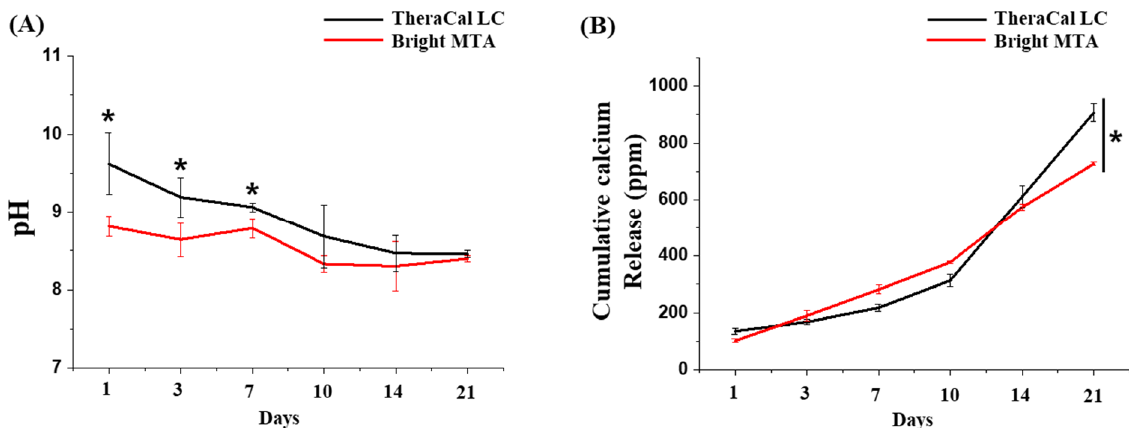
Figure 3. Ion release and pH changes from TheraCal LC and bright MTA capping over time. ( A ) The pH change was similar between TheraCal LC and bright MTA capping (n = 5). Asterisks (*) indicate statistical significance between bright MTA and TheraCal LC at the same pH ( p < 0.05). The pH value fluctuated between pH 8 and 9 ( p < 0.05, n = 5). ( B ) Calcium ions were similarly released for up to 10 days, with similar profile patterns between TheraCal LC and bright MTA capping, but after 10 days, TheraCal LC released more calcium ions than bright MTA capping ( p < 0.05, n = 3). The ability of TheraCal LC and bright MTA capping to release calcium ions and alkalinize the surrounding fluids was correlated to the formation of calcium hydroxide Ca(OH) 2 .